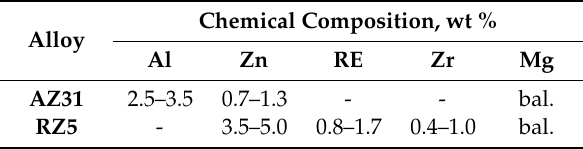
Table 1. Chemical composition of magnesium cast alloys applied as a matrix component.